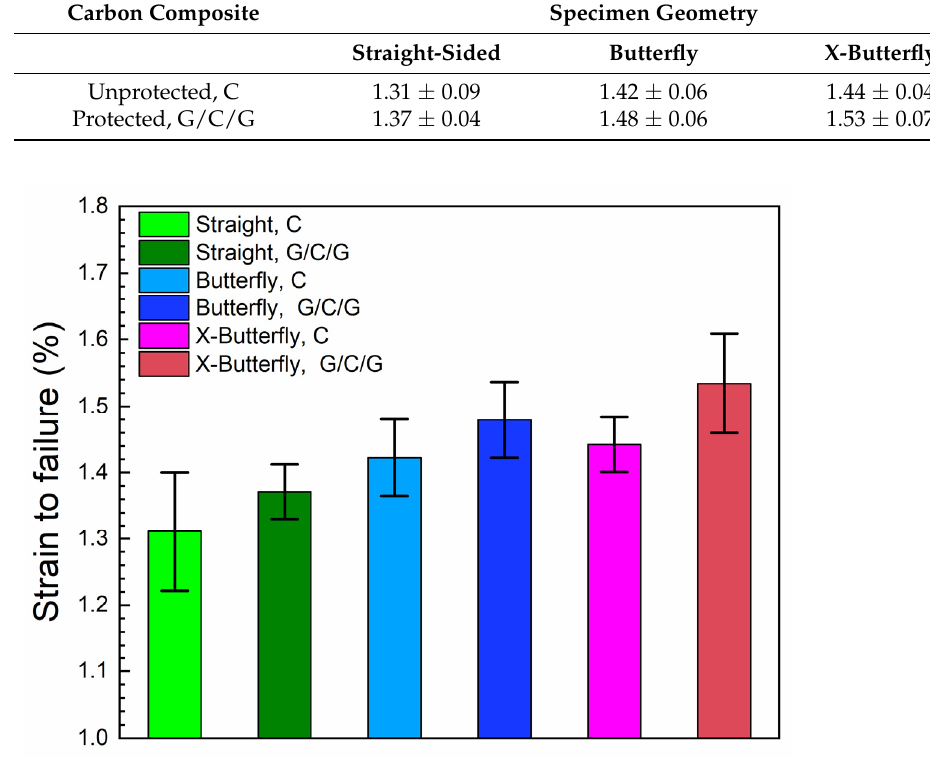
Figure 12. Bar graph representing strain to failure (%) for different specimen geometries of unpro- tected and protected carbon